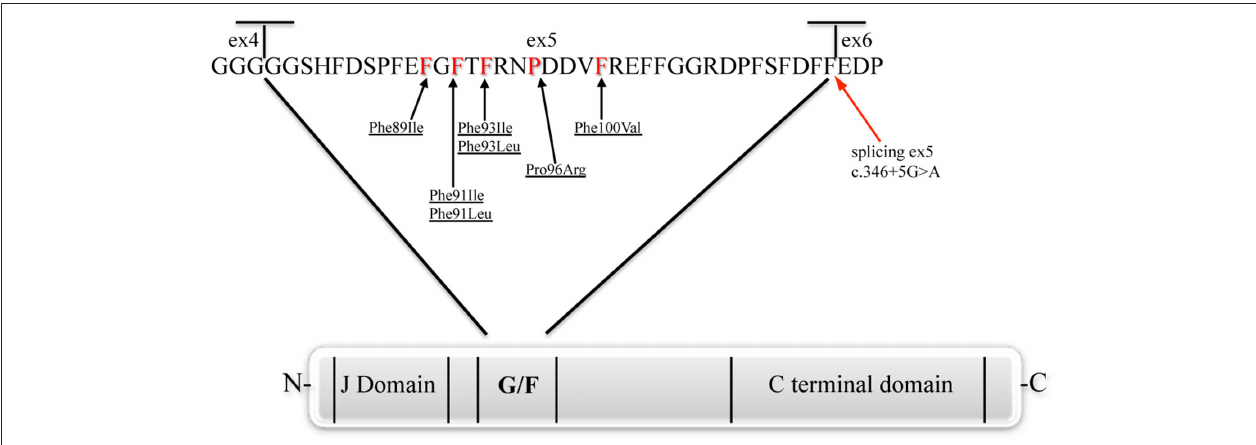
FIGURE 3 | The DNAJB6 protein. The J, G/F and C-terminal domains, and position of the amino acid and splicing mutations are represented (Fan et al., 2003; Sato et al., 2013; Ruggieri et al., 2015 ).